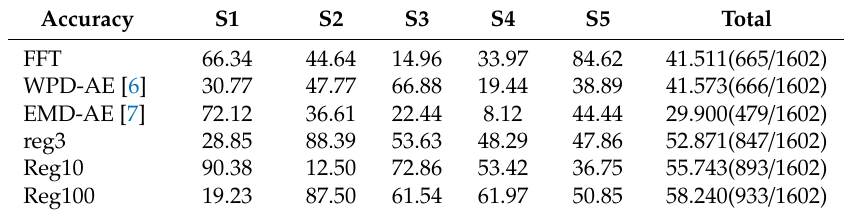
Table 4. SVM classification accuracy using the classical feature extraction methods in MFE.